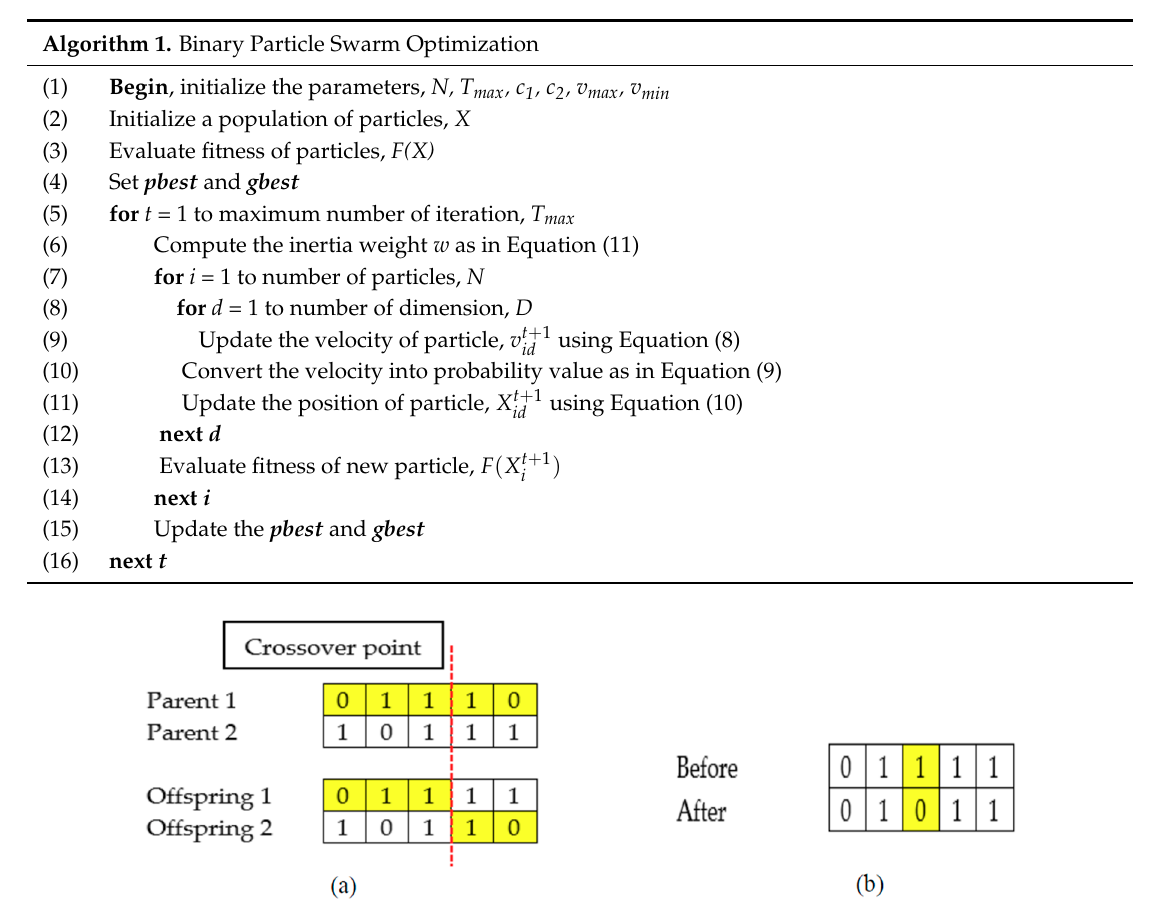
Figure 3. Example of genetic algorithm (GA) operations. ( a ) Crossover, and ( b ) mutation.